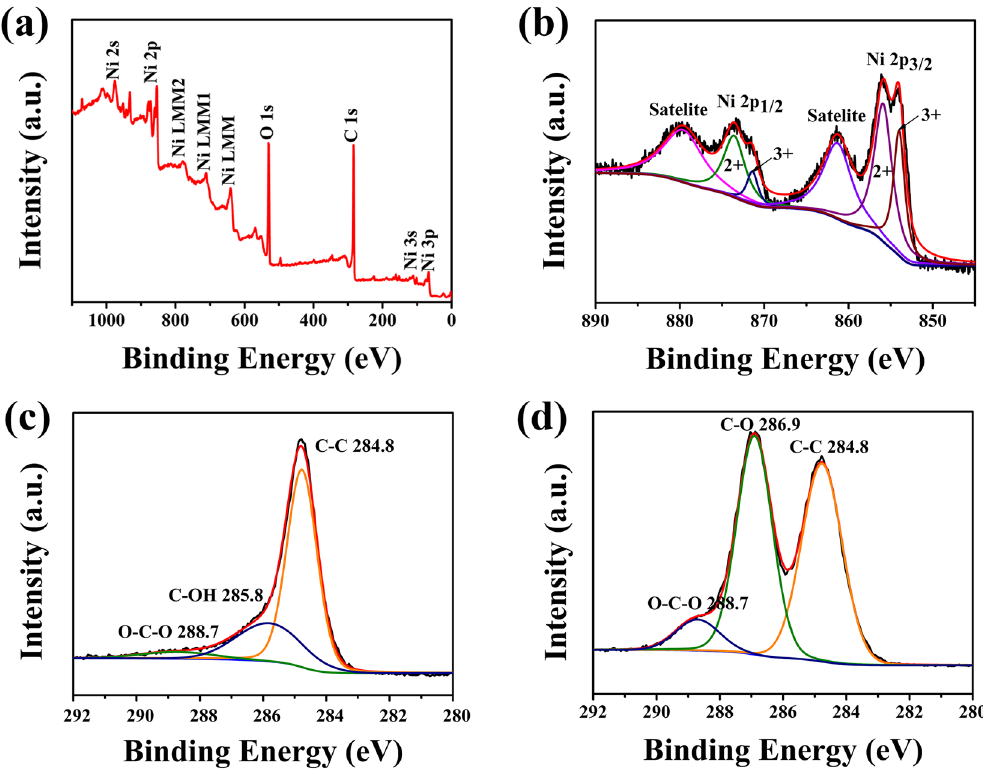
Figure 5. XPS spectra of NiO hollow sphere/rGO composite: ( a ) Survey spectrum, ( b ) Ni 2 p , ( c ) C 1 s ; ( d ) C 1 s XPS spectrum of GO.